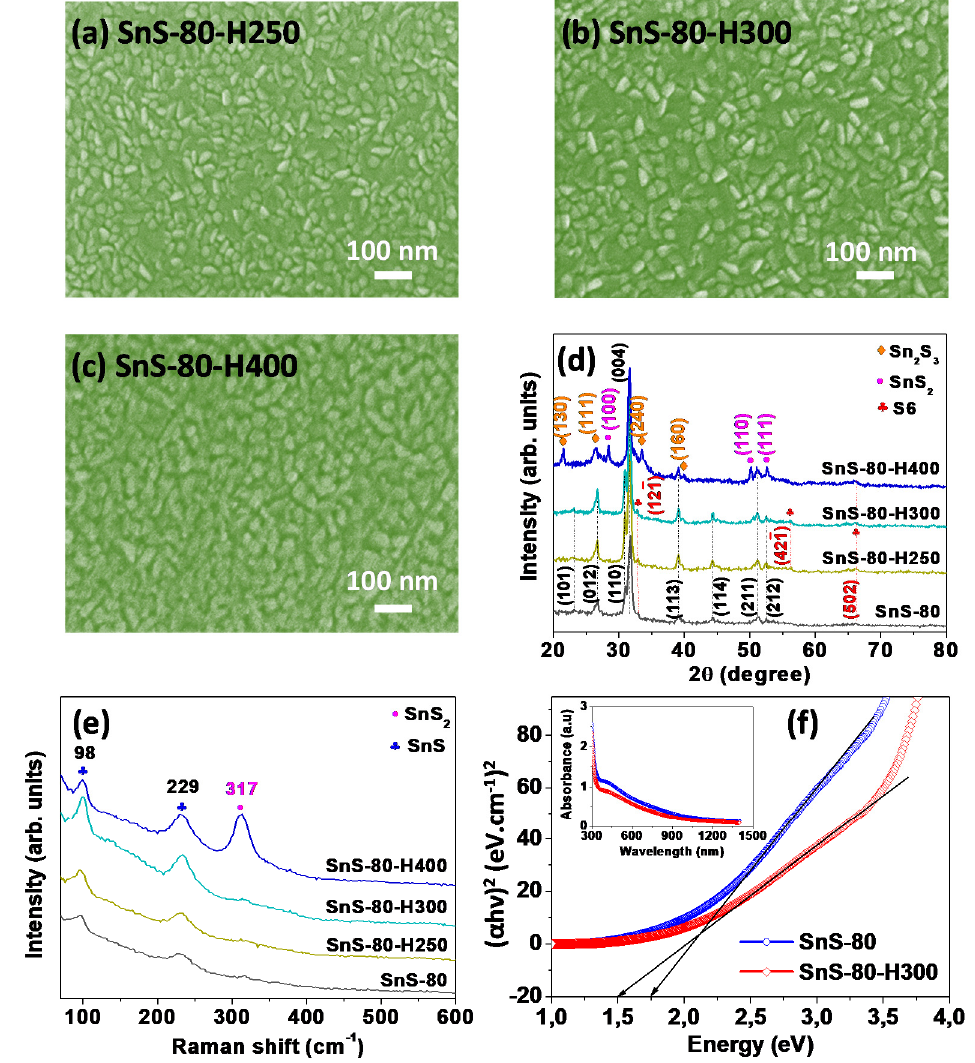
Figure 4. ( a – c ) SEM surface images of SnS-80 thin films annealed at di ff erent temperatures (250–400 ◦ C): ( a ) 250 ◦ C (SnS-80-H250), ( b ) 300 ◦ C (SnS-80-H300), and ( c ) 400 ◦ C (SnS-80-H400). ( d ) Corresponding XRD and ( e ) Raman spectra of SnS-80 thin films annealed at di ff erent temperatures (250–400 ◦ C) and that of the as-deposited SnS-80 thin film. ( f ) Tauc plots for the as-deposited SnS-80 and SnS-80-H300 thin films. The inset shows the corresponding absorbance curves.